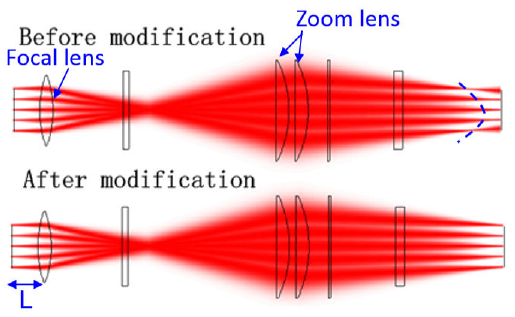
Figure 3. Gaussian beam tracing of the radio frequency optics before and after the optics modification.